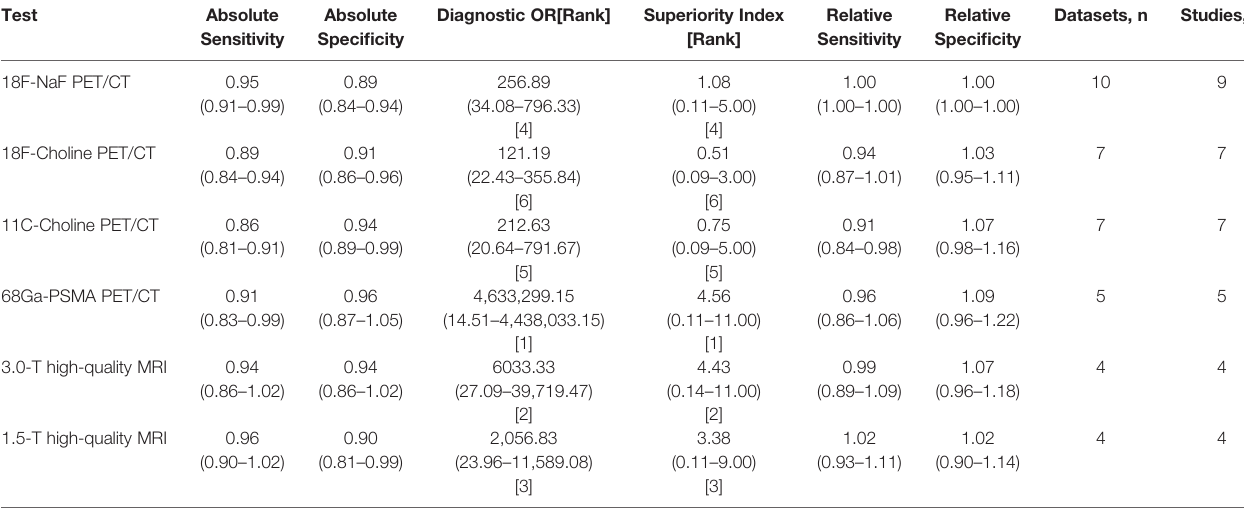
TABLE 3 | PET/CT with different tracers and high-quality MRI to detect bone metastasis in